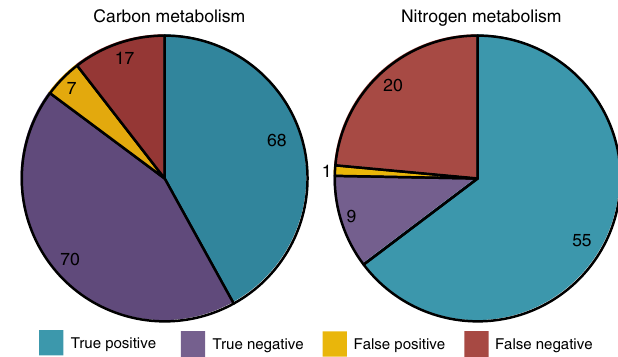
Figure 1 | Agreement between experimental and in silico metabolic capabilities of S. meliloti . True positives, growth was observed experimentally and in silico . True negatives, growth was not observed